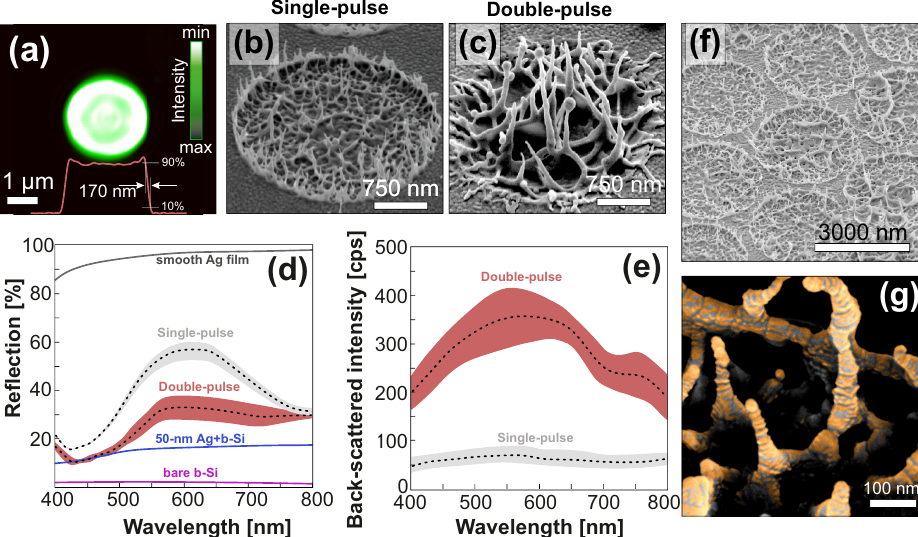
Figure 2. Optimization of plasmonic performance of the sensor element. ( a ) Focal-plane intensity distribution of the flat-top laser beam used to produce spallative textures of the central site. Central cross-sectional intensity profile is also shown in this image by the red curve. ( b , c ) Side-view (view angle 40 ◦ ) SEM images of spallative craters produced on the surface of 600-nm thick Ag film under single- and double-pulse laser irradiation. ( d , e ) Reflection and dark-field back-scattering spectra measured from the surface area patterned with spallative craters that were produced under single- and double-pulse irradiation. Colored areas near spectra indicate standard deviations from at least 20 spectra measured on different craters. Reflection spectra from a smooth Ag film, as well as from bare and Ag-coated black silicon, are provided as references for comparison on figure ( d ). ( f ) Side-view (view angle 40 ◦ ) SEM image of spallative textures arranged in a hexagonal array with a fixed pitch of 3 µ m. ( g ) Close-up false-color SEM image showing non-uniform coverage of isolated nanospikes with Au nanoclusters upon deposition of a 25-nm thick gold film above the spallative